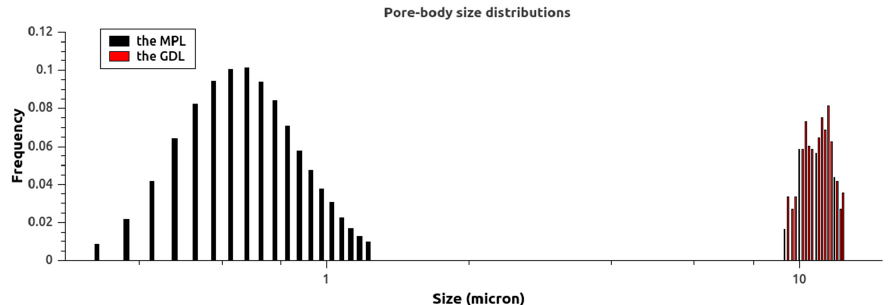
Figure 1. ( a ) x - y view of the GDL and MPL pore-network structures; ( b ) one x - z slice of the MPL; and ( c ) a snapshot of the interface between the GDL and MPL. The MPL is three-dimensional, while the connected GDL has only one layer along the z direction.